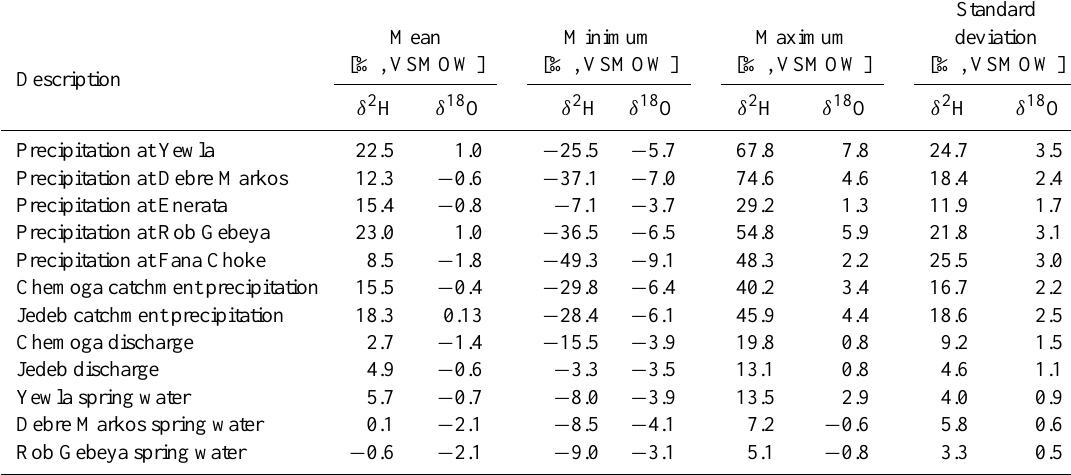
Table 3. Mean, range and standard deviation of δ 2 H and δ 18 O [‰, VSMOW] amount-weighted concentration for precipitation and volume weighted for discharge and non-weighted for spring water during different investigation